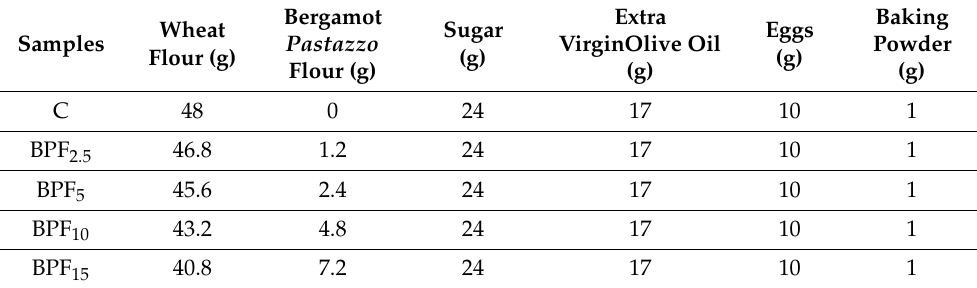
Table 1. Sample composition (g 100 g − 1 of sample) and denomination of biscuits.